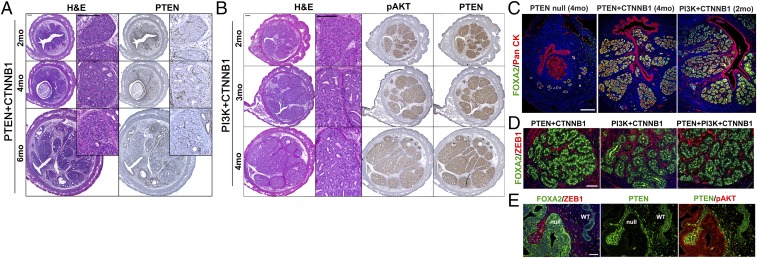
Development of glandular hyperplasia in the uteri from mice carrying the combination of CTNNB1 mutation with PTEN LOF or PI3K GOF mutation. Histopathological analyses of uteri carrying CTNNB1 GOF mutation with Pten biallelic loss (A) or PI3K GOF (B) mutation at indicated time points (months). The loss of PTEN (A) and the expression of pAKT (B) in epithelial lesions. (C) Glandular hyperplasia lesions were positive for uterine gland marker (FOXA2) and were organized in normal lobular structures. (D) Each gland in the hyperplastic lesions was separated by ZEB1-positive interstitial stromal cells. (E) FOXA2 was excluded from the nucleus of UtE with biallelic Pten loss. (Scale bars: A–C, 200 μm; D and E, 50 μm.)